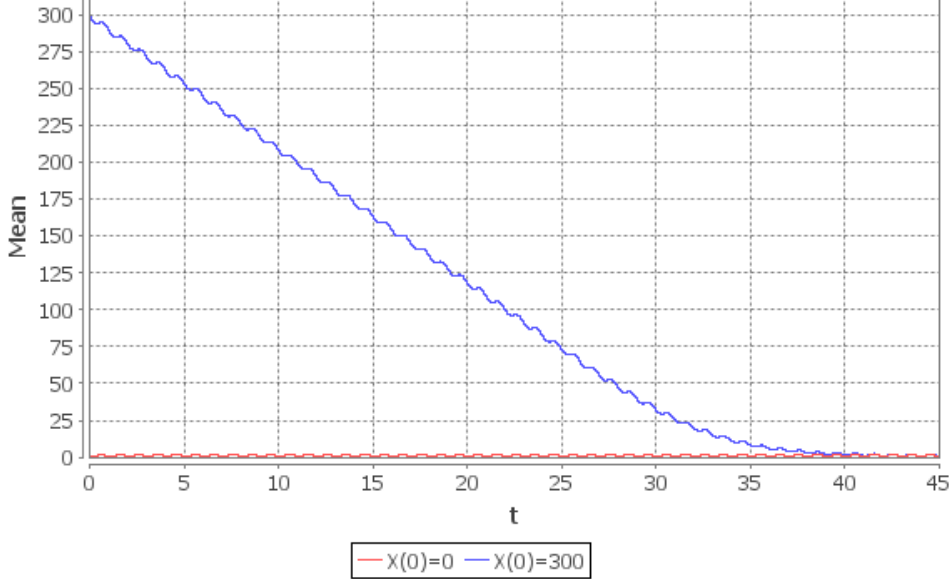
Figure 11. Rate of convergence of the conditional mean E ( t , k ) number of customers in the system in the interval [ 0,45 ] : E ( t ,0 ) ( red line ), E ( t ,300 ) ( blue line